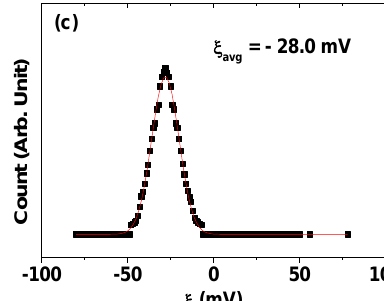
Figure 2. ( a ) HRTEM image (dotted circles indicate PASA-coated Gd 2 O 3 nanoparticles). ( b ) Log-normal function fit to the particle size distribution to obtain d avg . ( c ) Log-normal function fit to a DLS pattern to obtain a avg .